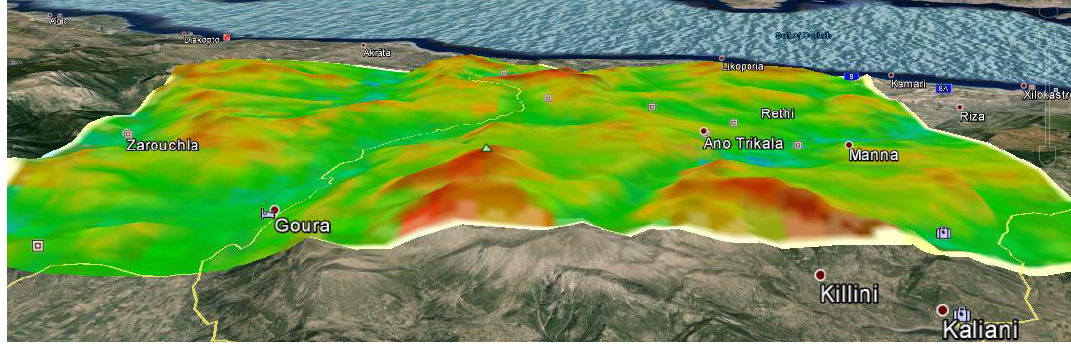
Figure 4. An orographic map of the